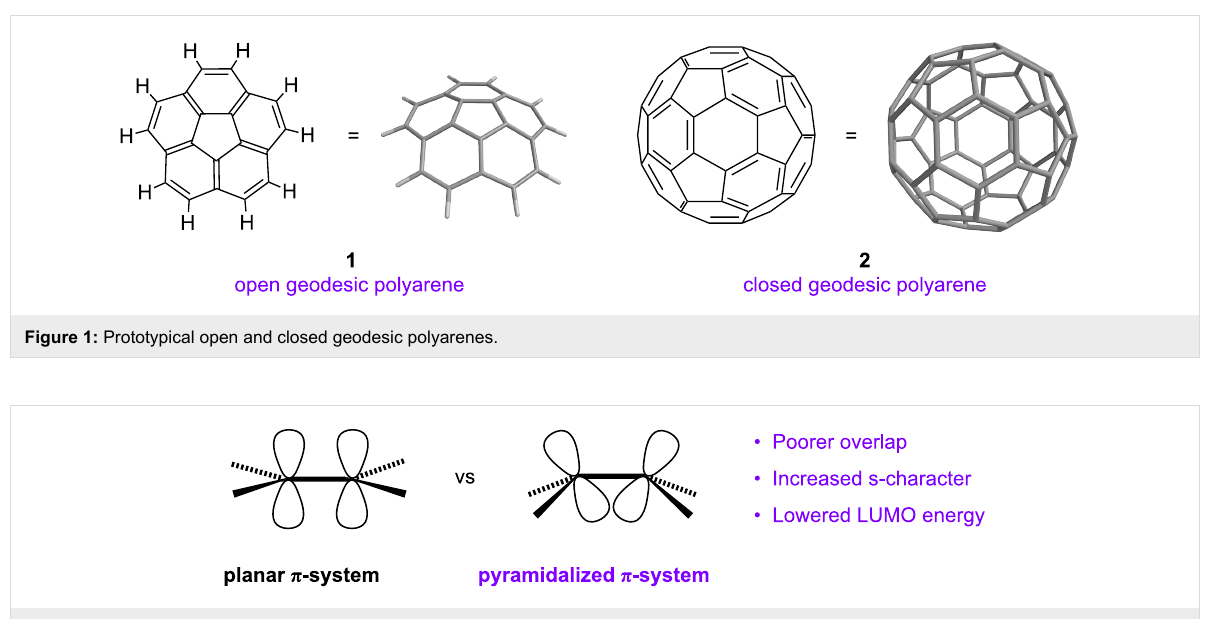
Figure 2: Planar vs pyramidalized π